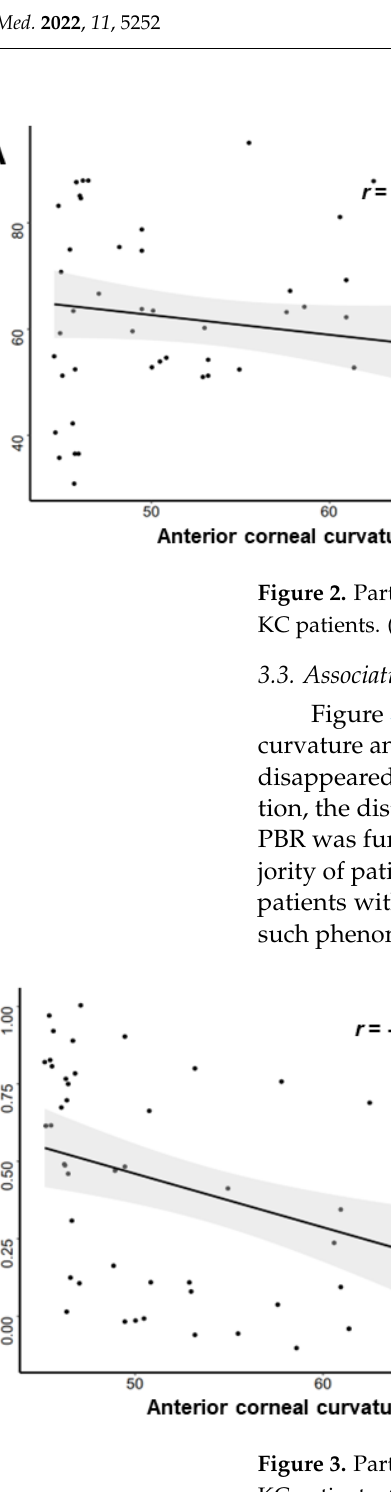
Figure 3. Partial correlogram of PBR and anterior corneal curvature. ( A ) Correlation of the overall KC patients. ( B ) Correlation of the KC patients with different severity. Sub 1, 2 represent total blink rates of < 8 and > 8, respectively.